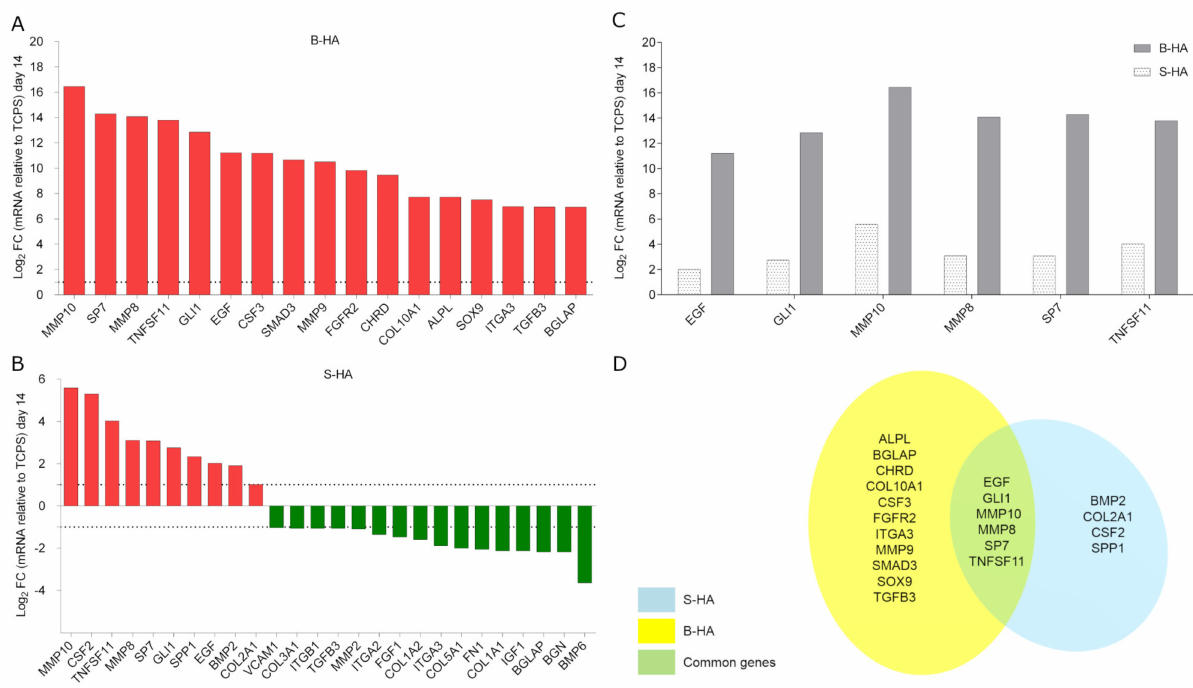
Figure 4. RT 2 PCR Array analyses of osteogenic genes. Gene expression was evaluated in human adipose stem cells (hASCs) grown on ( A ) biomorphic HA (B-HA) and ( B ) sintered HA (S-HA), compared to tissue culture polystyrene (TCPS) at day 14. ( A ) In hASC cultures, mRNAs from 17 genes in the osteogenic pathway, i.e., ALPL, BGLAP, CHRD, COL10A1, CSF3, EGF, FGFR2, GLI1, ITGA3, MMP10, MMP8, MMP9, SMAD3, SOX9, SP7, TGFB3 and TNFSF11 were up-regulated (red). ( B ) In hASC cultures, mRNAs of 10 genes in the osteogenic pathway, i.e., BMP2, COL2A1, CSF2, EGF, GLI1, MMP10, MMP8, SP7, SPP1, TNFSF11 were up-regulated (red), while 16 tested genes resulted down-regulated (green): BGLAP, BGN, BMP6, COL1A1, COL1A2, COL3A1, COL5A1, FGF1, FN1, IGF1, ITGA2, ITGA3, ITGB1, MMP2, TGFB3 and VCAM1 . ( C ) Fold change (FC) of common up-regulated gene EGF, GLI1, MMP10, MMP8, SP7, TNFSF11 . ( D ) Genes modulated by B-HA and S-HA in hASC cultures at day 14 are represented by Venn diagram. The common genes up-regulated from both biomaterials are